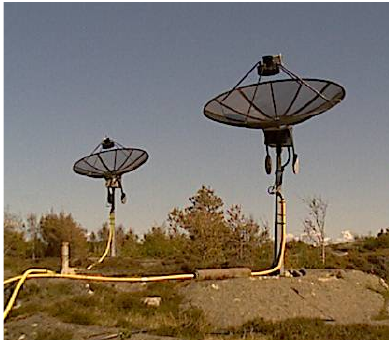
Figure 1. The 2.3 m radio telescopes of the Onsala Space